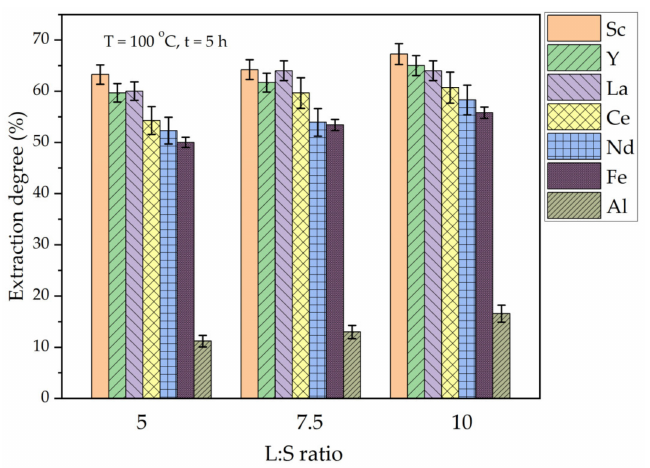
Figure 7. The effect of L/S ratio on the extraction degree of REEs, Fe, and Al from DCFA by (NH 4 ) 2 SO 4 + H 2 SO 4